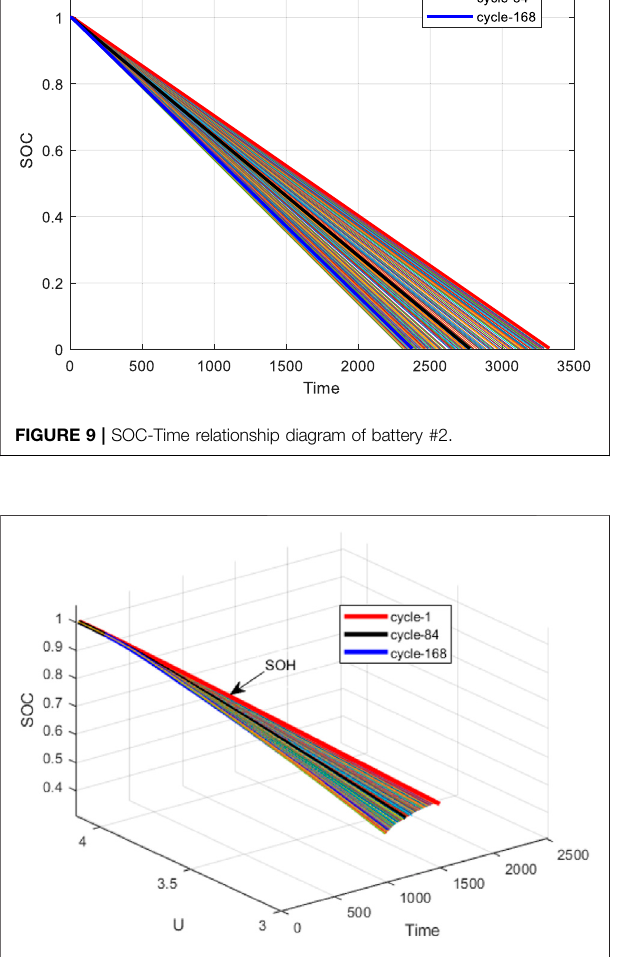
FIGURE 8 | SOH-SOC-U relationship diagram of battery #2.